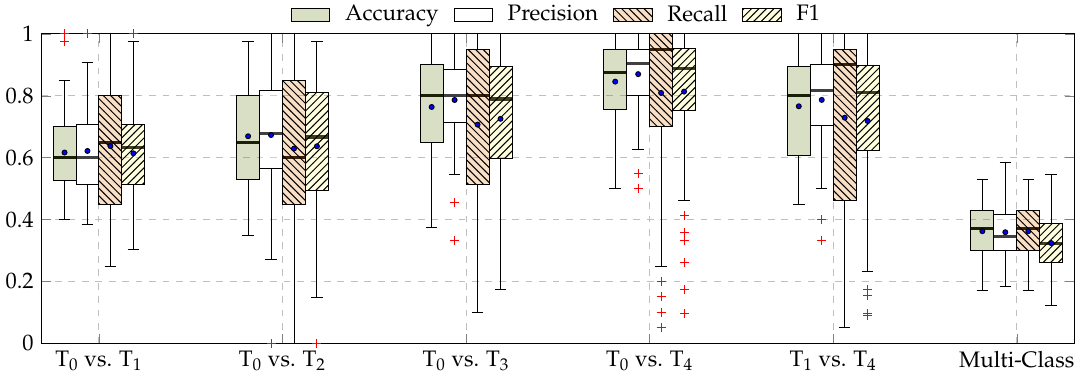
Figure 6. EDA classification performance. Within each box plot, the mean and median values of the respective performance evaluation metrics are depicted with a dot and a horizontal line,